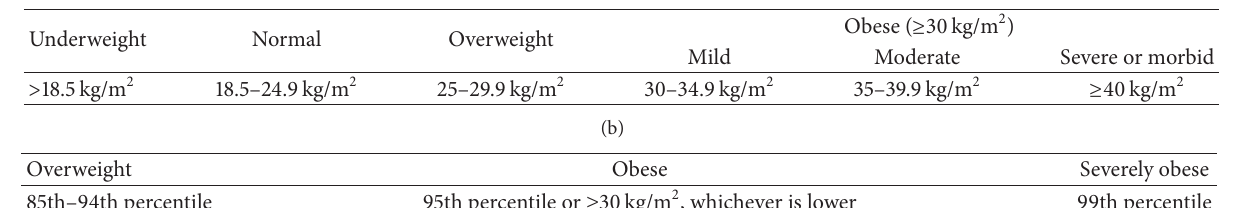
Table 1: (a) Adults and (b)